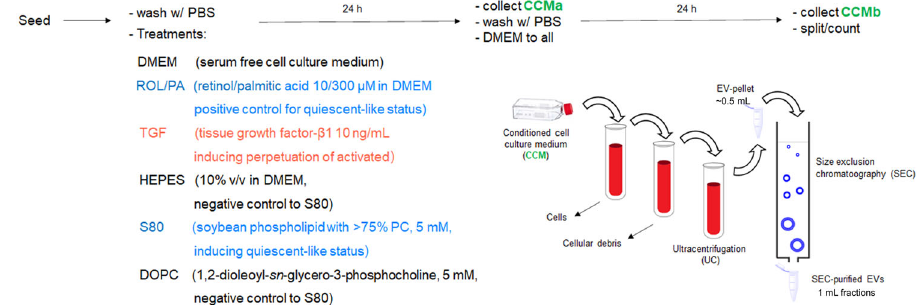
Fig. 1 Work fl ow of EV isolation and puri fi cation protocols from LX-2 cells. Schematic overview of the protocols to obtain highly puri fi ed EVs from LX-2 cells subjected to different treatments.